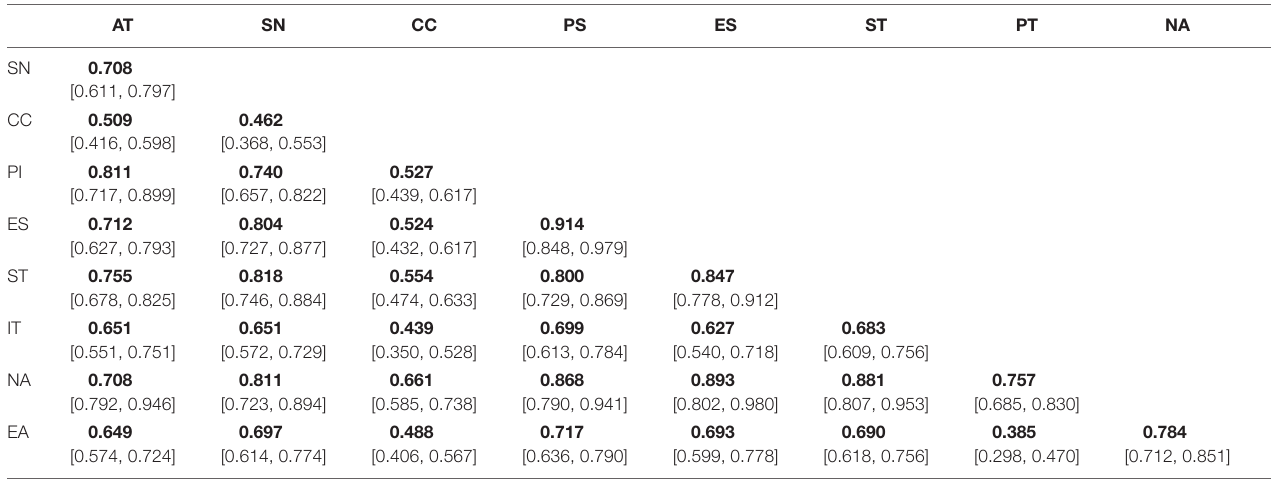
TABLE 3 | Heterotrait–monotrait ratio (HTMT) and confidence interval. AT